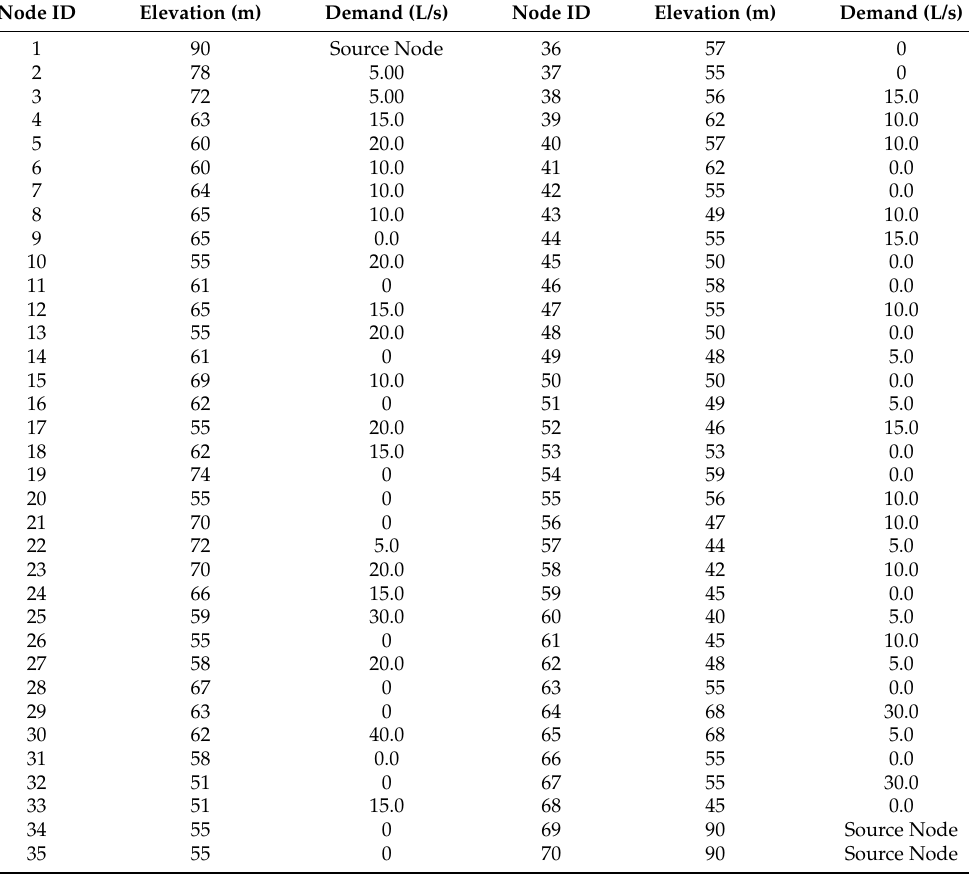
Table A2. Node data for case study network